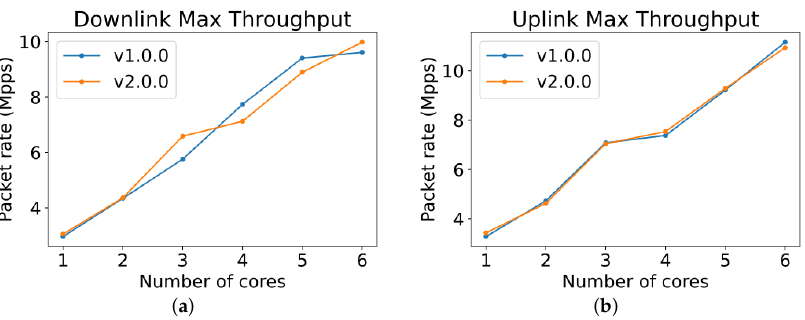
Figure 16. Scalability of the proposed solution. The solution achieves almost 10 Mpps for downlink and 11 Mpps for uplink with packet loss less than 0.5%. ( a ) Downlink. ( b ) Uplink.